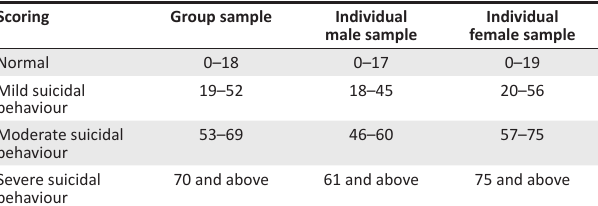
TABLE 7: Interpretation of Redeemer’s University Suicidality Scale scores.